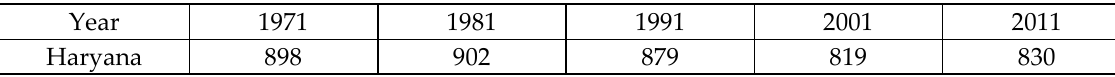
Table 1: Child Sex-ratio (0-6 years) for Haryana since 1971. Source: Census of